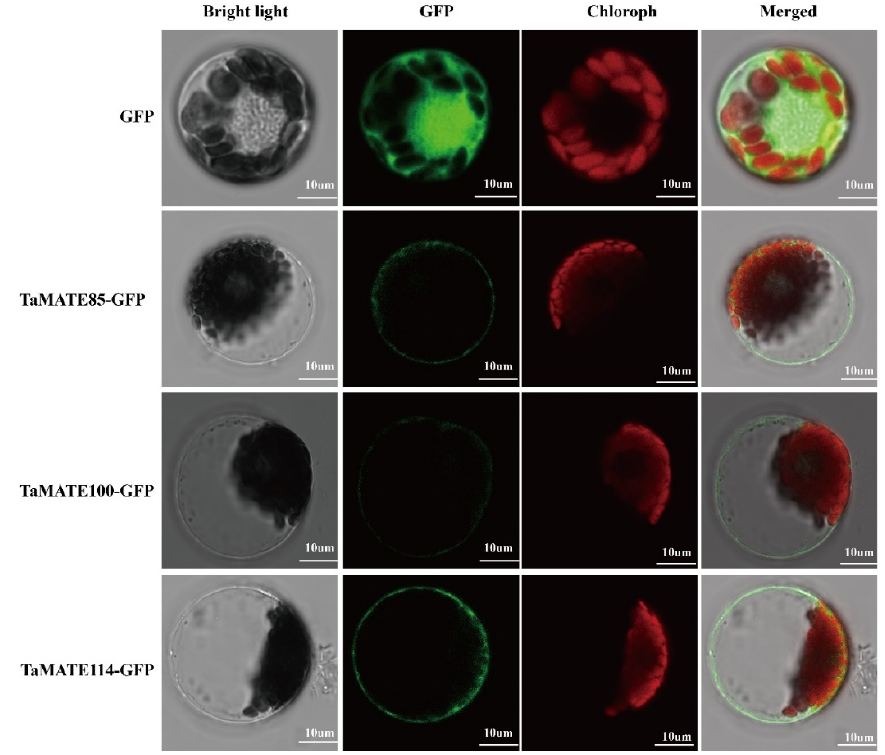
Figure 4. Subcellular localisation of TaMATE85, TaMATE100 and TaMATE114 in wheat leaf protoplast. GFP, GFP fluorescence signal; chloroph, chlorophyll autofluorescence signal; bright light, bright field image; merged, merge of GFP fluorescence signal, chlorophyll autofluorescence signal, and bright field image.